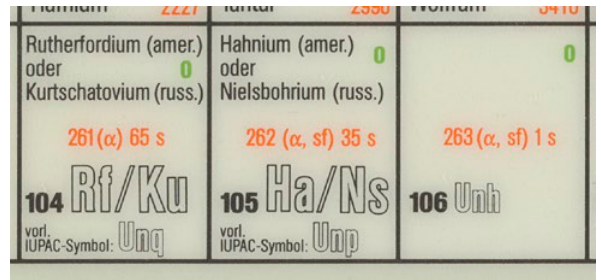
Figure 6. Detail from a 1988 periodic table wallchart (Central Sci- entific Company) showing the IUPAC systematic nomenclature for elements with an atomic number greater than 100 (Photo taken by the author at Wellesley College, September